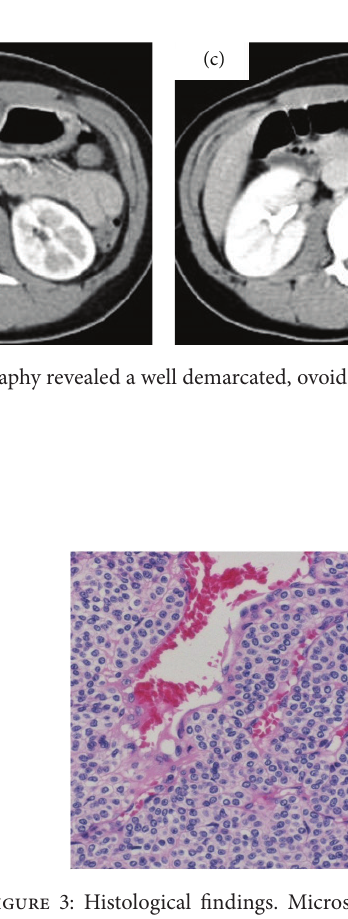
The tumor was completely resected and was determined not to be severely malignant based on the detection of few cells undergoing mitosis and the observation of few atypical cells. We therefore chose not to provide adjuvant therapy while continuing to monitor the patient through